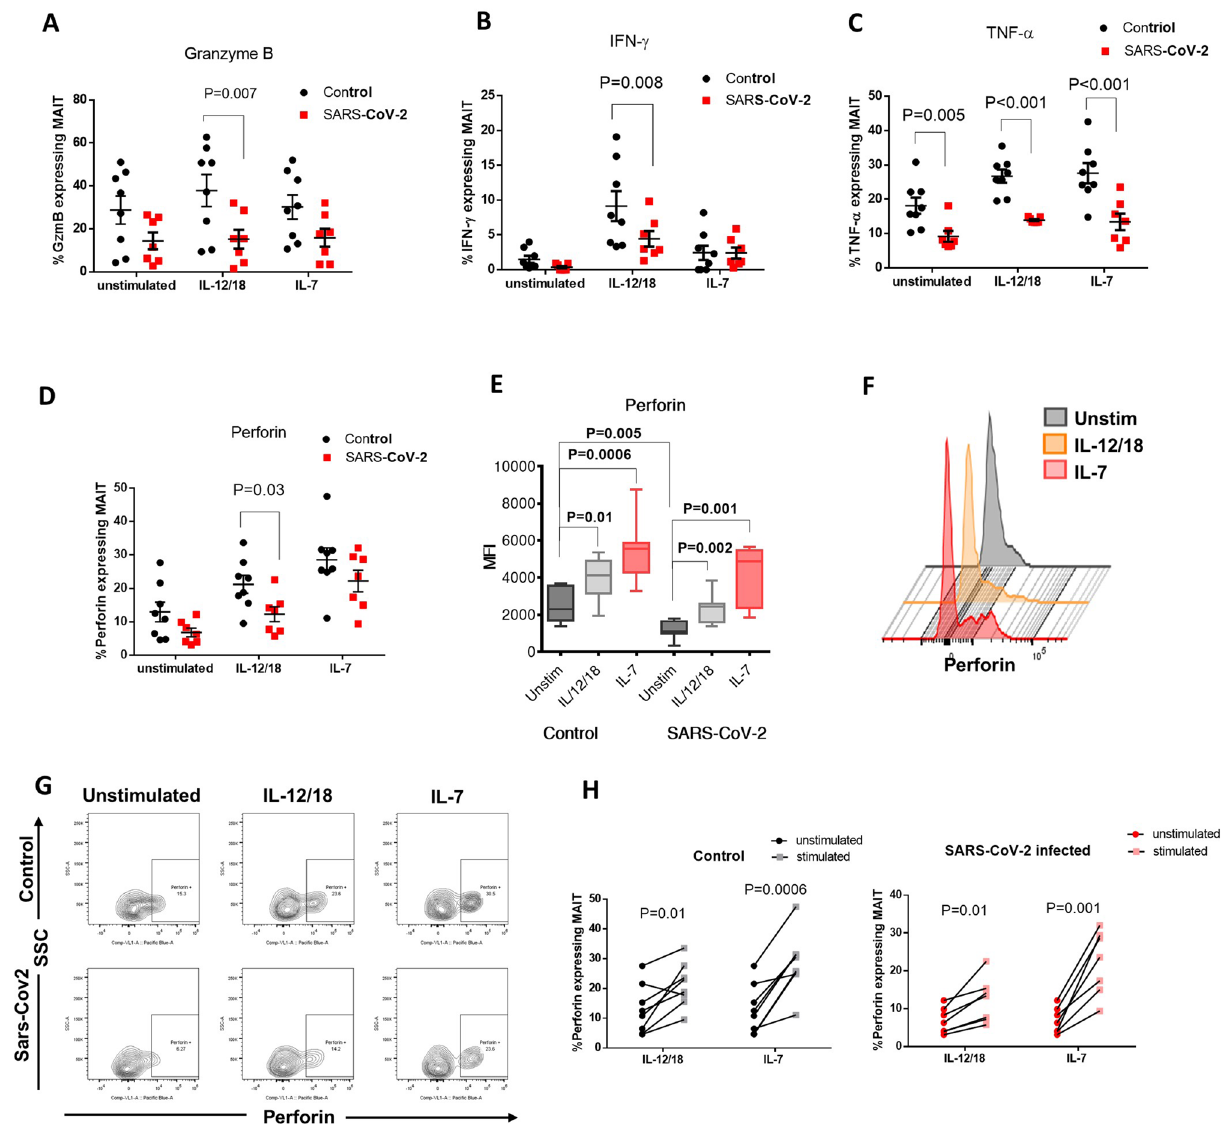
Figure 2. Effect of SARS-CoV-2 infection on the function of MAIT cells measured by the expression levels of cytokine and cytolytic proteins upon in vitro stimulation. Frequency of MAIT cells expressing ( A ) granzyme B ( B ) IFN-γ, ( C ) TNF-α and ( D ) perforin in PBMCs isolated from the peripheral blood of COVID-19 patients (presenting with mild symptoms) compared to uninfected individuals with or without stimulation with a combination of IL-12 and IL-18 or IL-7 alone. Multiple t-tests with Holm-Sidak’s correction for multiple comparisons were conducted to compare the SARS-CoV2 infected group with the control uninfected group; bars show the standard error of the mean. ( E ) Mean fluorescence intensity (MFI) of perforin in MAIT cells isolated from control and infected individuals. Mann–Whitney t-test was conducted to compare the unstimulated patients and control groups, and paired t-tests were used to compare stimulated and unstimulated cells within each group, bars show maximum and minimum values ( F ) Histogram representation of perforin expression in MAIT cells of a mildly affected individual that were either unstimulated or incubated with IL-12/18 nor IL-7 for 24 h. ( G) Flow cytometric analysis of MAIT cells expressing perforin, showing an example of a control individual and a SARS-CoV2 infected patient. ( H ) Percentage of MAIT cells expressing perforin in the control and patient groups with or without stimulation with IL-12/18 or IL-7 alone. Paired t-tests were conducted to determine statistical significance between stimulated and unstimulated